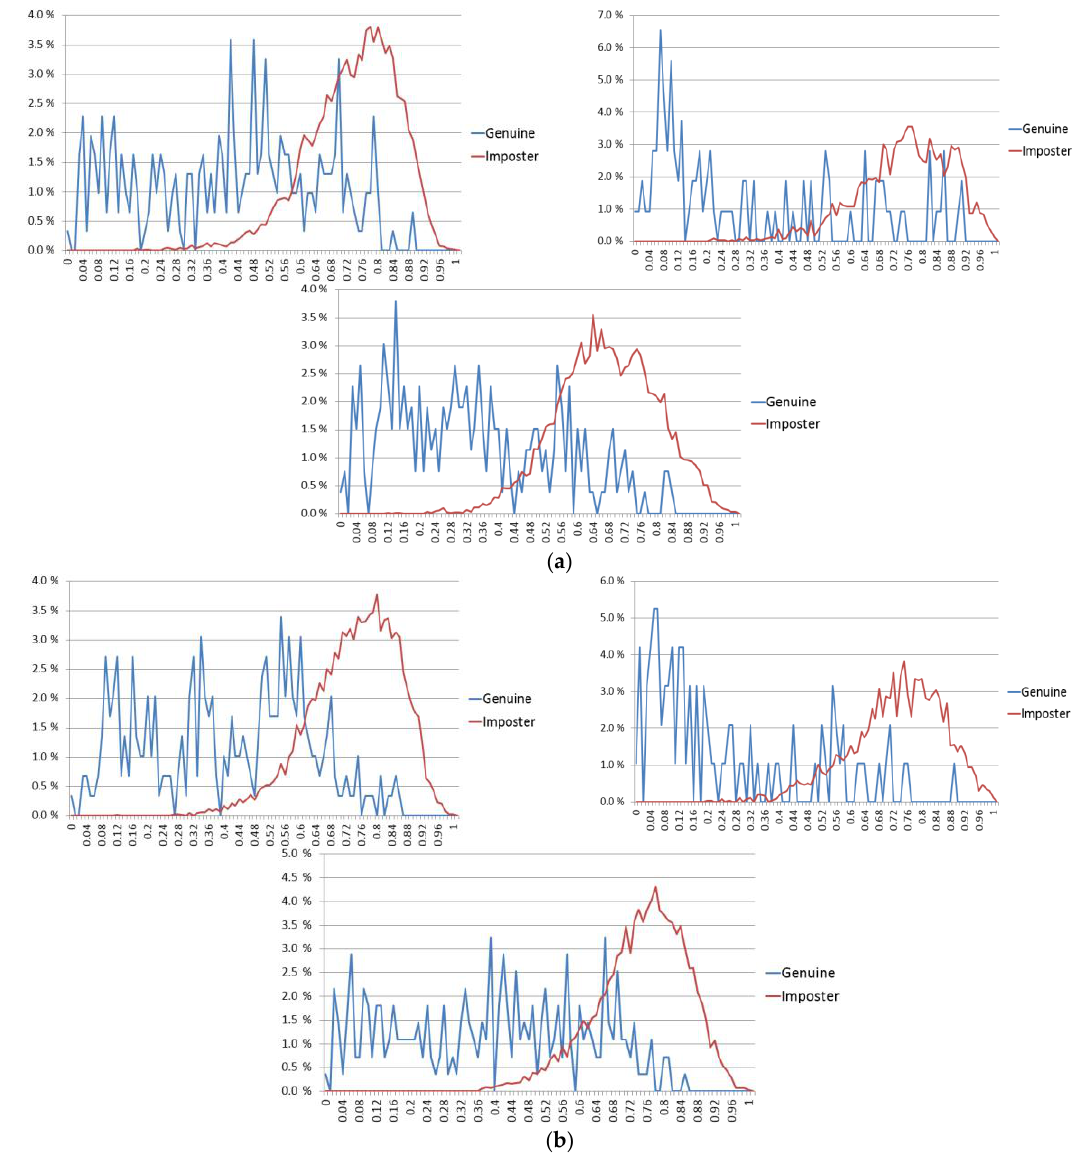
Figure 12. Graphical representations of clients (genuine) and imposters with testing data of the NICE.II dataset. ( a ) First fold cross-validation; ( b ) second fold cross-validation.